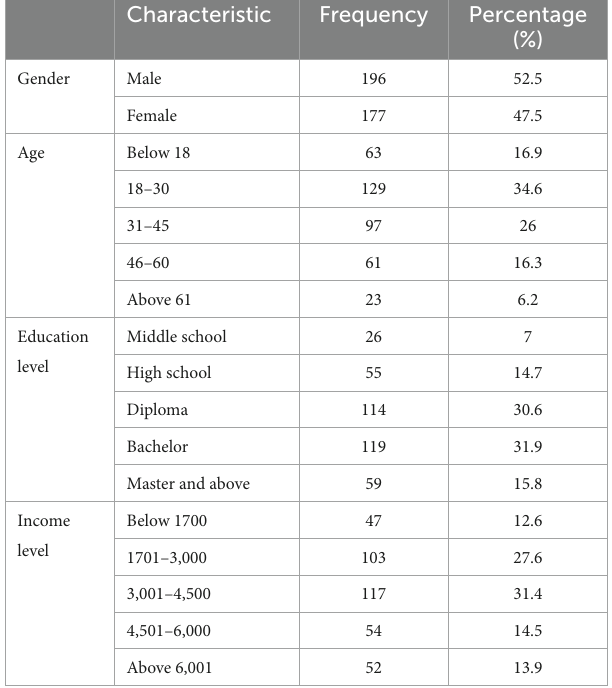
TABLE 1 Sample characteristics ( N =